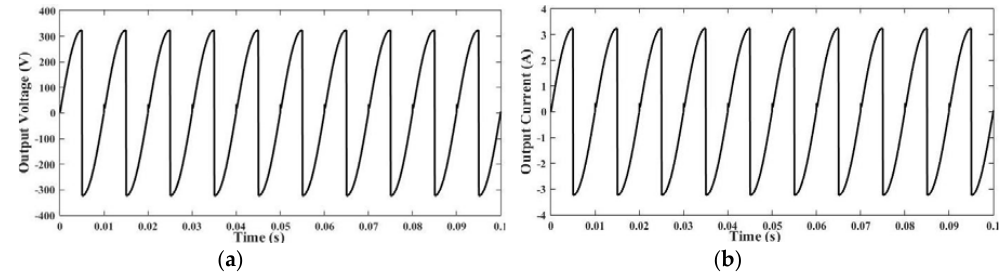
Figure 8. Simulated waveforms of ( a ) input voltage ( V in ) ( b ) input current ( I in ) and ( c ) THD analysis of input current ( I in ).